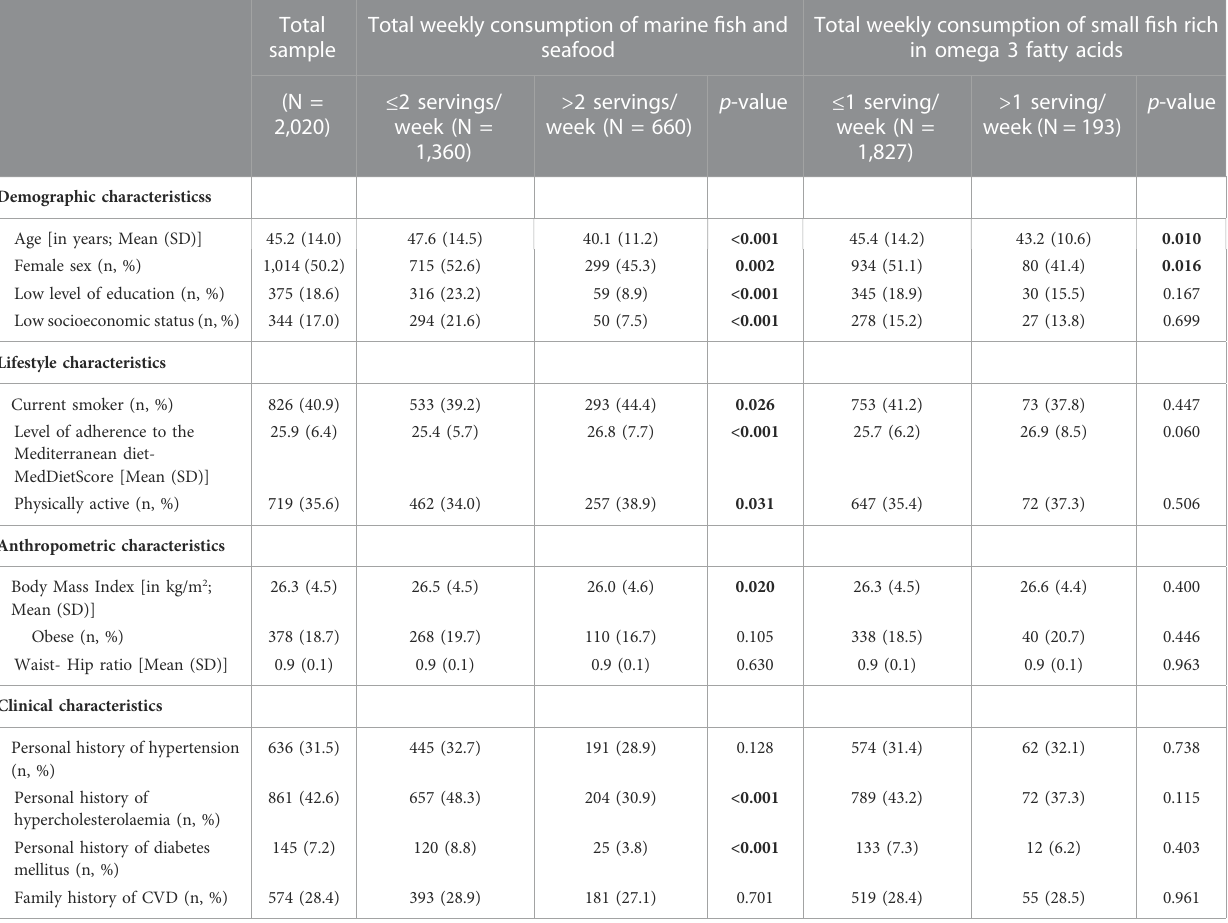
TABLE 1 Baseline demographic, lifestyle, anthropometric and clinical characteristics of the study population according to total weekly consumption of fi sh and seafood: The ATTICA Cohort Study, 2002-2012. Total Total weekly consumption of marine fi sh sample